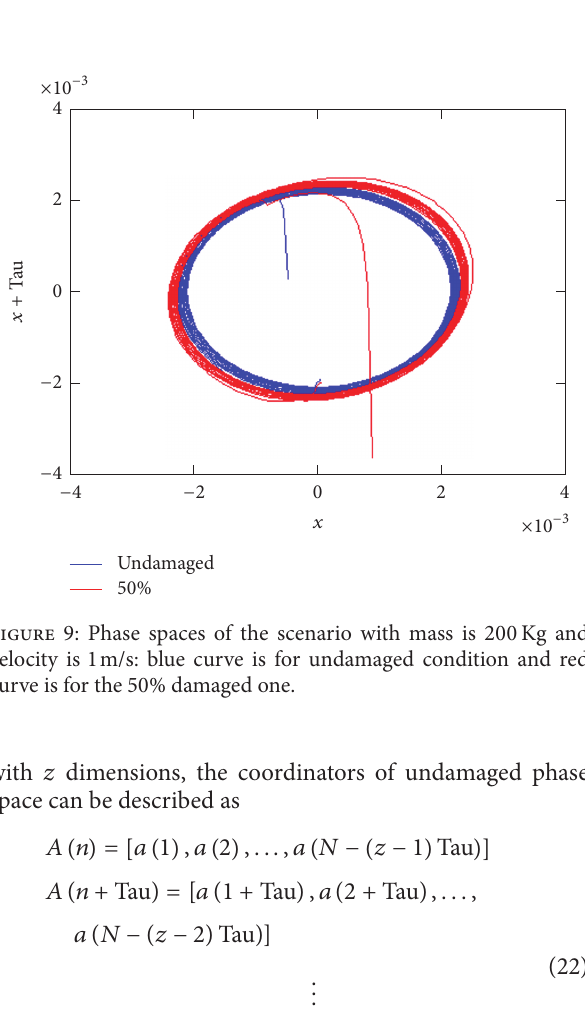
Figure 7: Acceleration components of the undamaged beam with mass velocity for 1m/s: (a) the maintained component with frequency for 1.07 Hz and (b) the high dynamic component with frequency for 4.44 Hz.